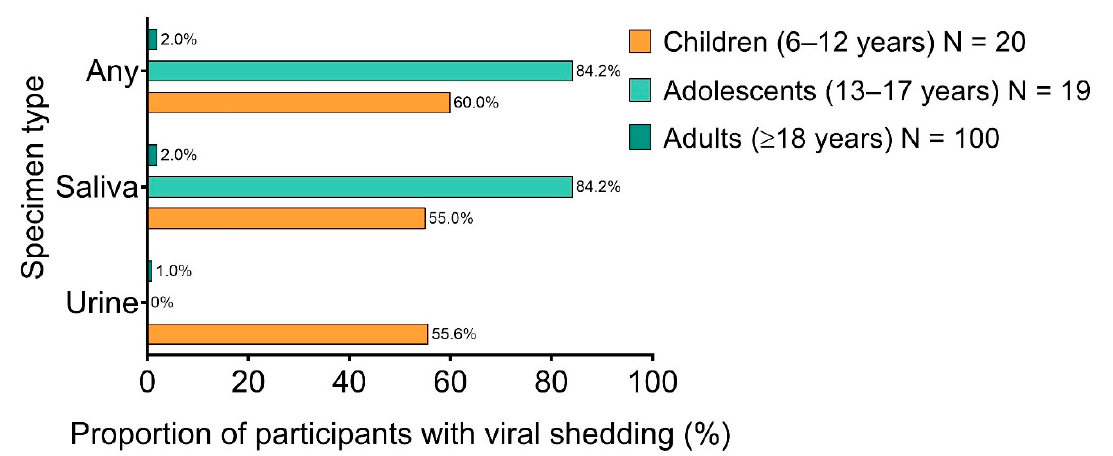
Figure 4. rVSV ∆ G-ZEBOV-GP shedding and excretion rates among participants in the V920-007 phase Figure 4. rVSV Δ G-ZEBOV-GP shedding and excretion rates among participants in the V920-007 1 clinical trial for whom corresponding data were phase 1 clinical trial for whom corresponding data were available.